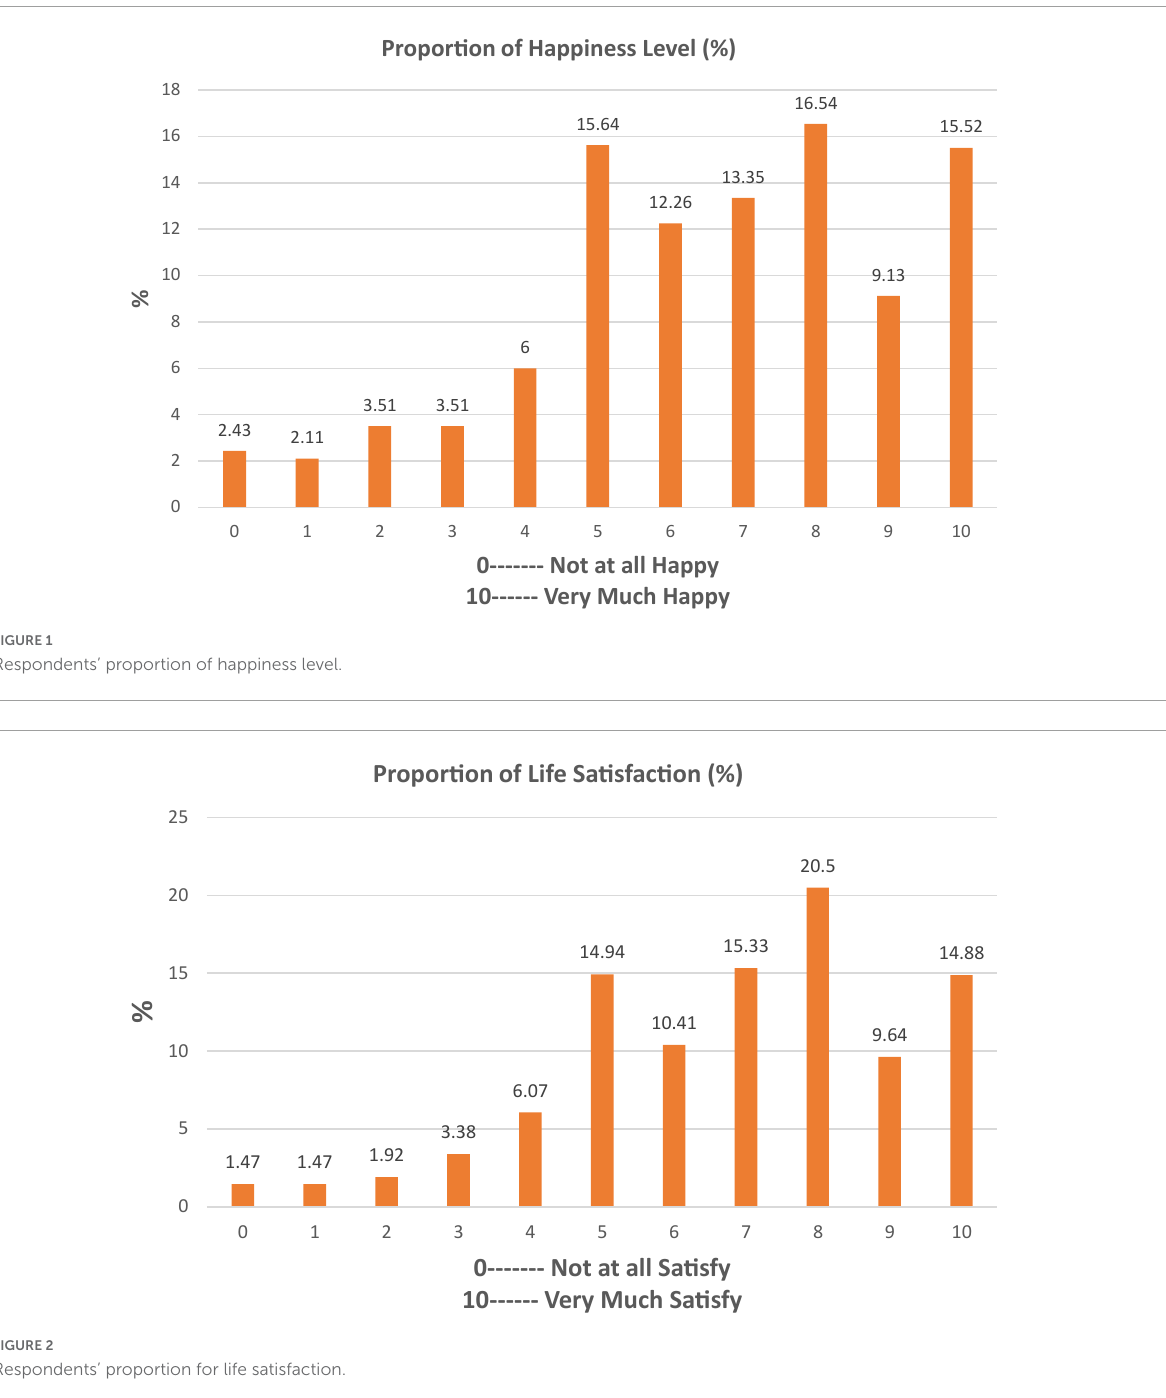
FIGURE2 Respondents’ proportion for life